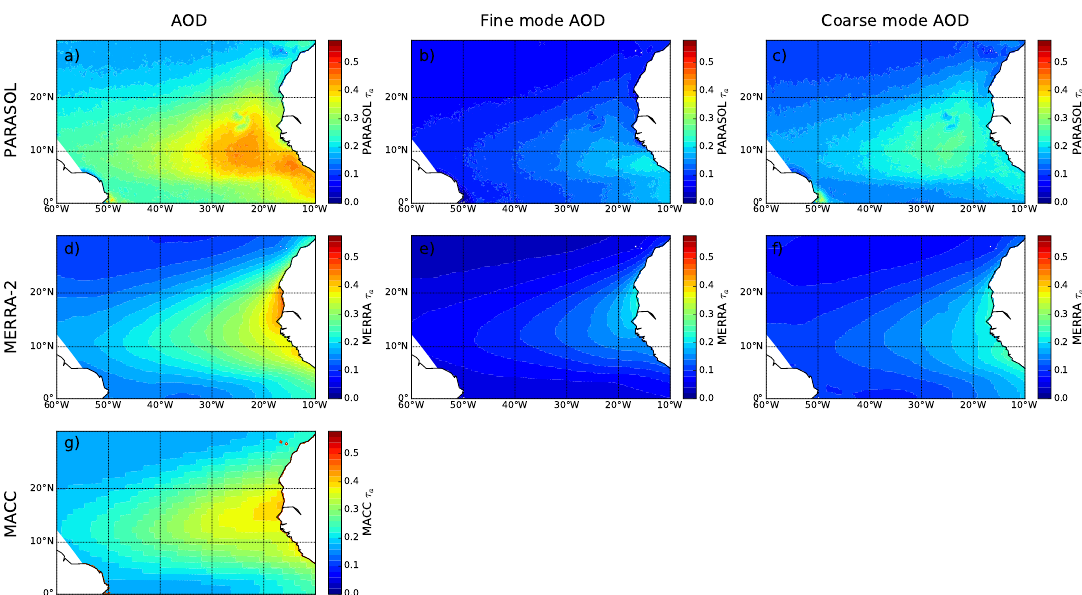
Figure 9. Spatial distribution of mean total AOD total (left column), mean AOD f (central column) and mean AOD c (right column) from ( a – c ) PARASOL satellite, ( d – f ) MERRA reanalysis and ( g ) MACC reanalysis averaged from 2005 to